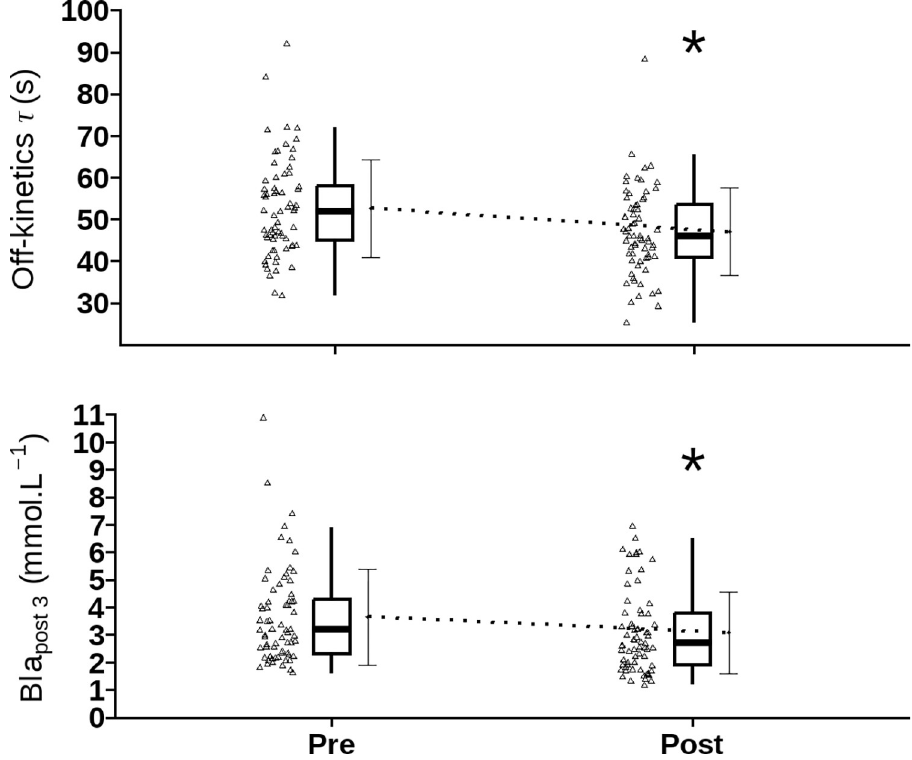
Fig 2. Effects of exercise training protocols on selected indices of _ V _ O off-kinetics and blood lactate during 2 recovery from female artistic gymnastics routines. Abbreviations: REGULAR, skill training; REGULAR+KB, regular skill training protocol + Kettlebell training; _ V _ O , oxygen uptake; BLa - post3 , blood lactate 3 minute following each 2 routine. * Indicates significant difference from values before interventions (p < 0.05).